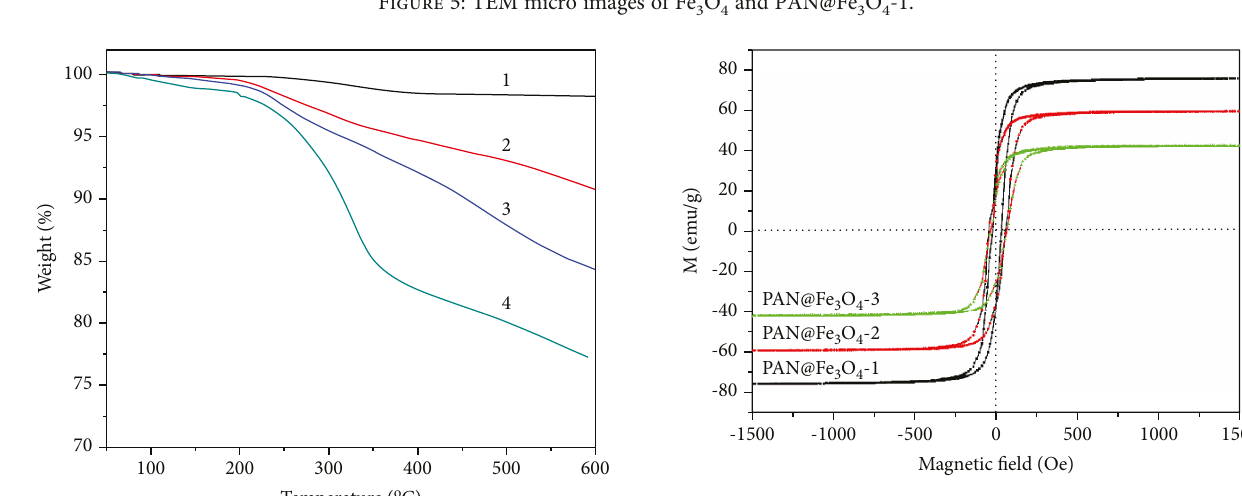
Figure 7: Magnetization curves of PAN@Fe and